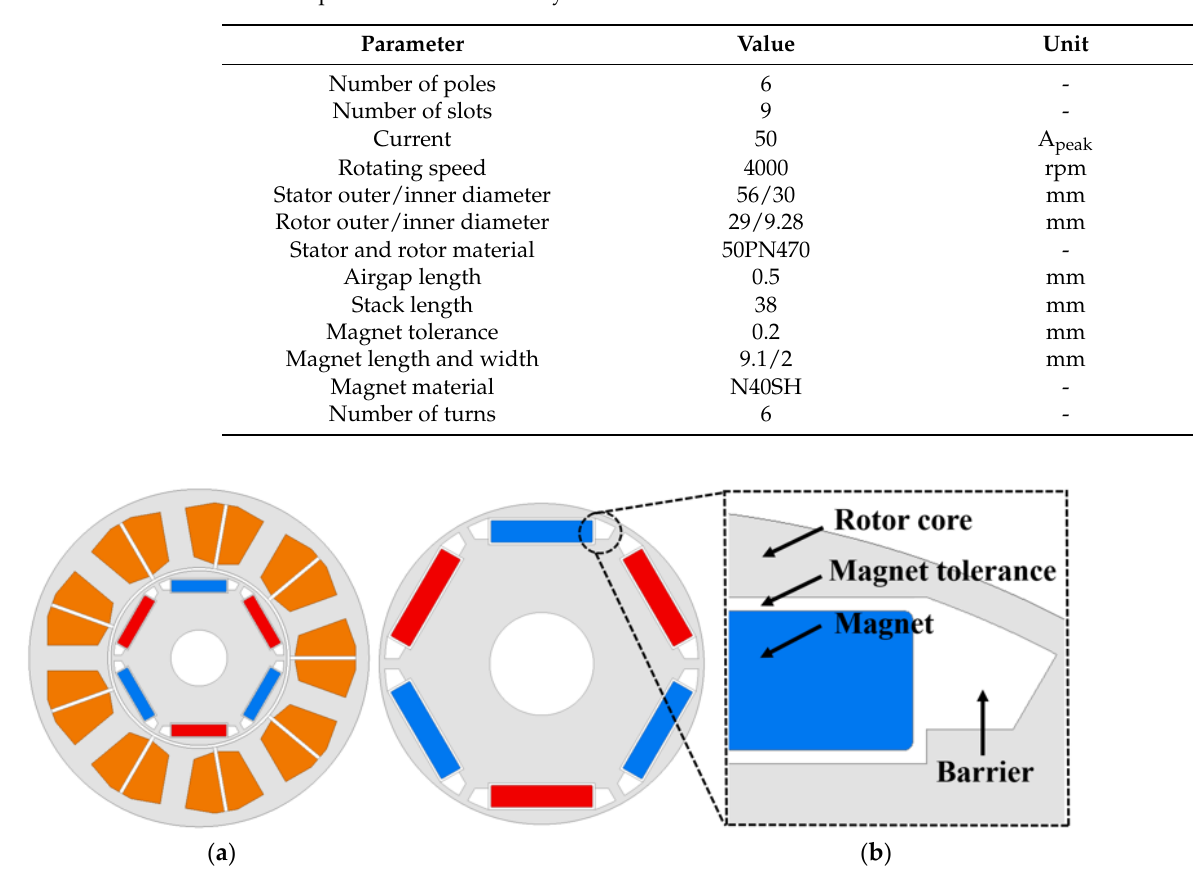
Table 1. Specifications of the analysis model.